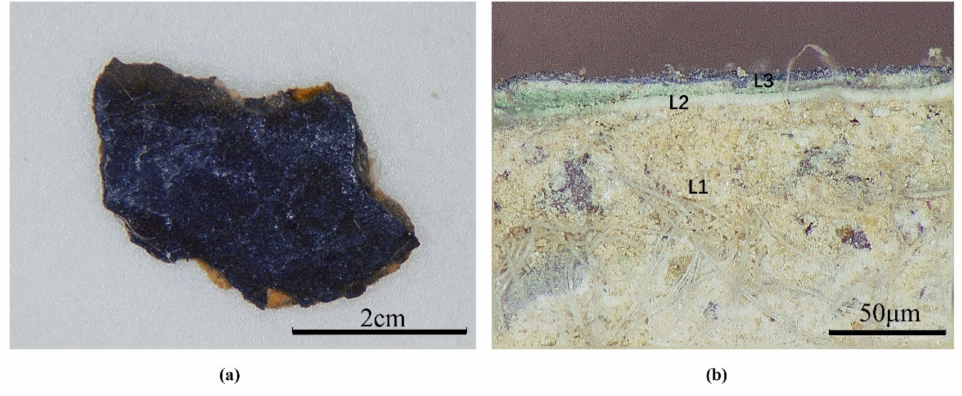
Figure 2. Digital microscopy (DM) of sample SJD-24 from the sculpture of Sakyamuni Buddha in the Xiasinan Hall: ( a ) surface; ( b ) cross-section (L1, clay ground layer; L2, white powder layer; L3, pigment layer).